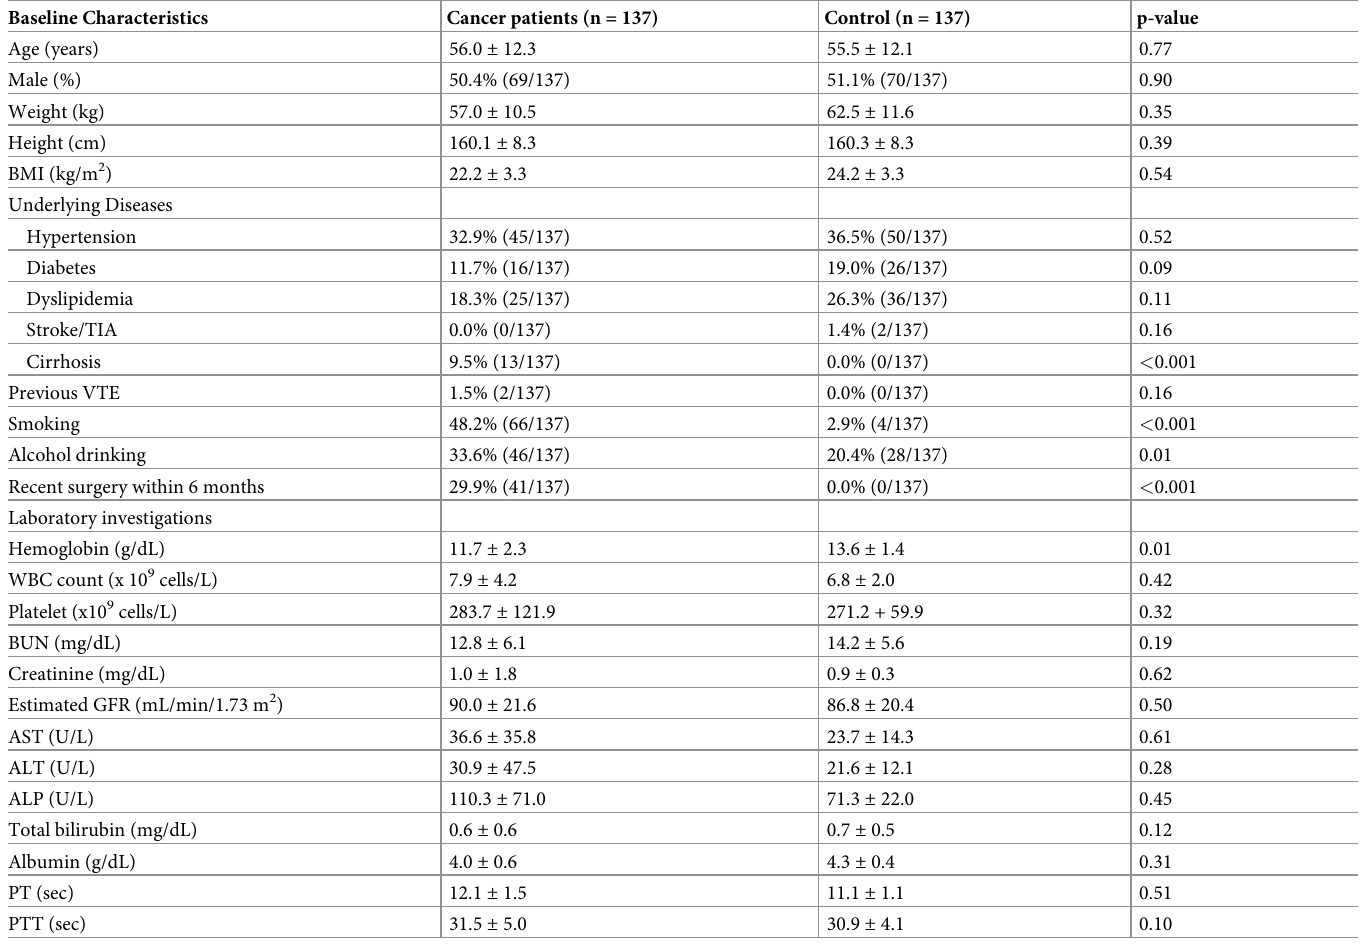
Table 1. Baseline characteristics of the cancer patients and control in this study. Baseline